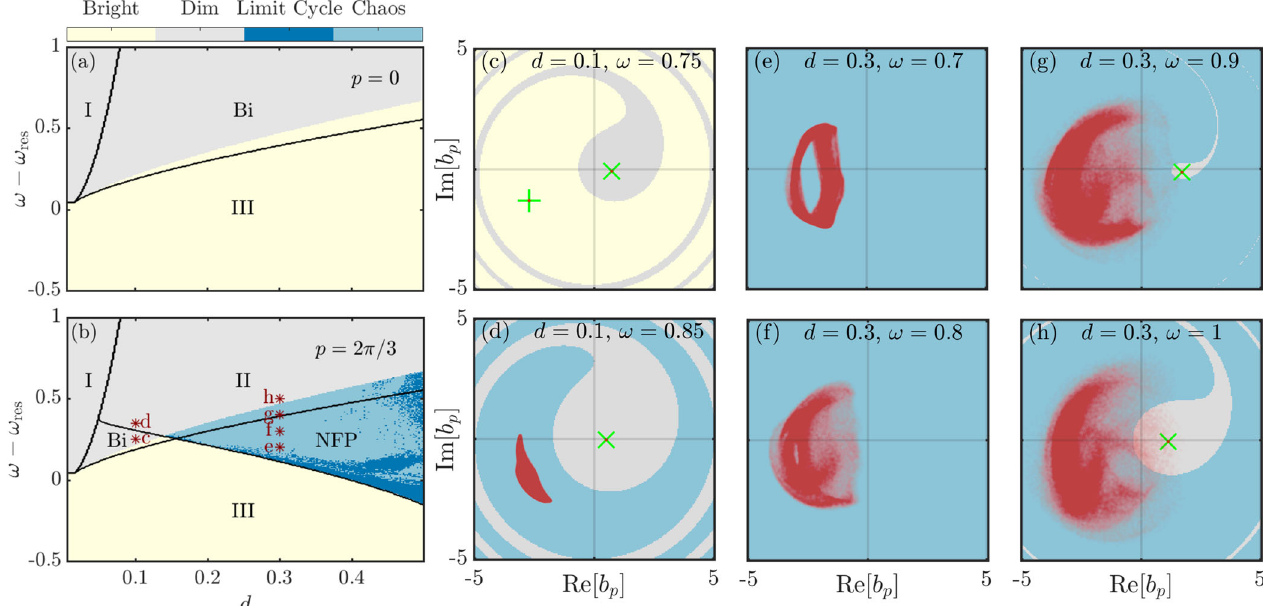
Fig. 2 Mean- fi eld phase diagram and classical basins of attraction for M = 3 cavities on a ring. Panels a and b display the phase diagram for zero momentum drive ( a ) and a fi nite p = 2 π /3 momentum drive ( b ), the latter giving rise to a chaotic regime. The phase diagrams are displayed as function of the strength of the drive ( d ) and its frequency ( ω ) with respect to the non-interacting resonant frequency ( ω res ¼ (cid:2) cos p ). The black lines delineate the bright (III), dim (I and II), and bistable (Bi) regimes, while for p = 2 π /3 a new regime appears where no fi xed point (NFP) remains stable. The shading of each point is determined by the long-time dynamical behavior when starting from the vacuum state, with most of the points in the NFP regime ending in chaotic dynamics. Panels c – h visualize the basins of attraction of the different attractors for a fi nite chiral drive: the chaotic basins (light blue), the bright fi xed point basin (yellow), and the dim fi xed point basin (gray) [see the red asterisks in ( b ) for the corresponding parameters]. The ending points of the sampled trajectory (for Jt m = 2000) are projected onto the resonant plane (red). The green × ( + ) markers correspond to the dim (bright) stable fi xed point solution. Here u = 0.1 and γ =